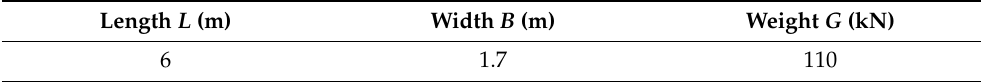
Figure 12. Comparison of the theoretical data and experimental data. Table 3. Main size of crawler in time-dependent traction force